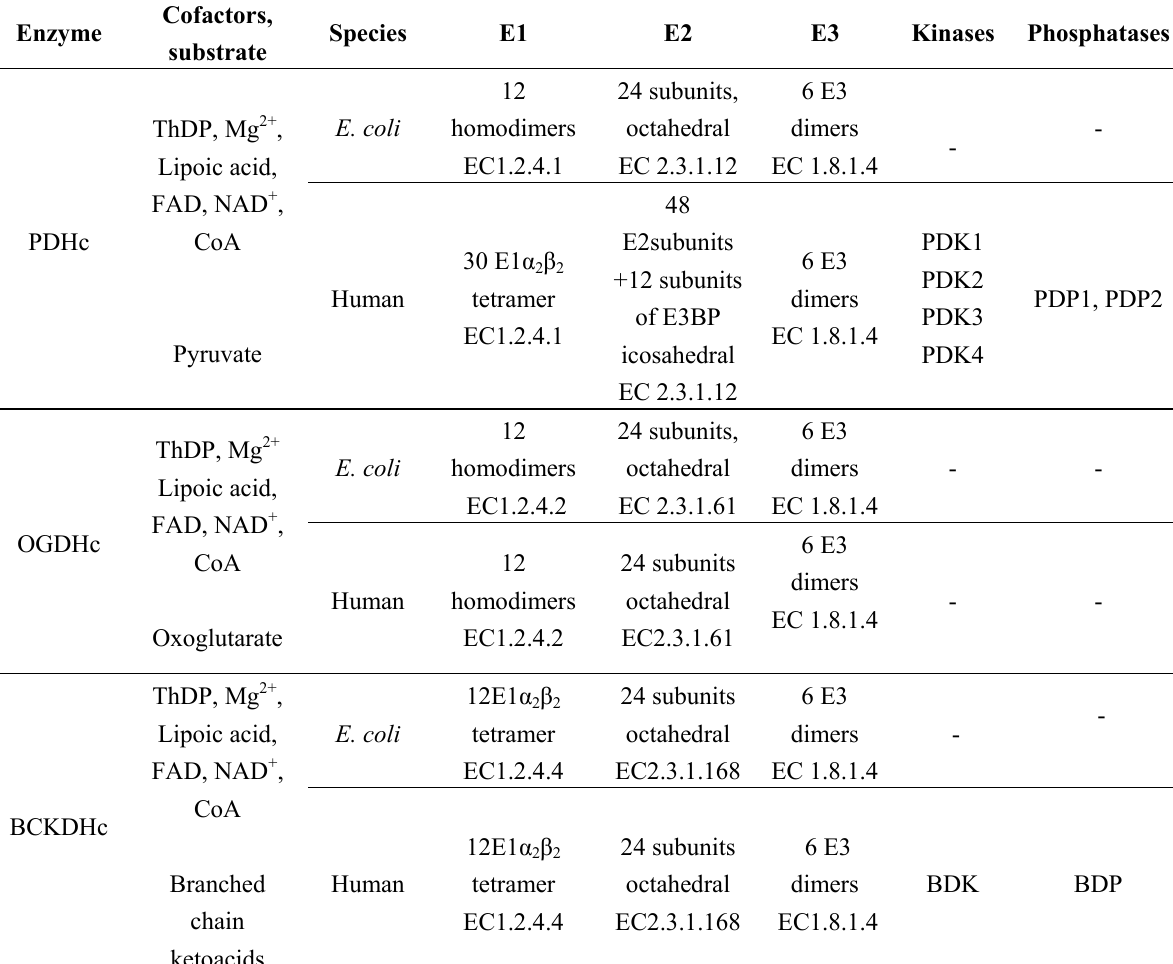
Table 1. Composition of 2-oxo acid dehydrogenase complexes